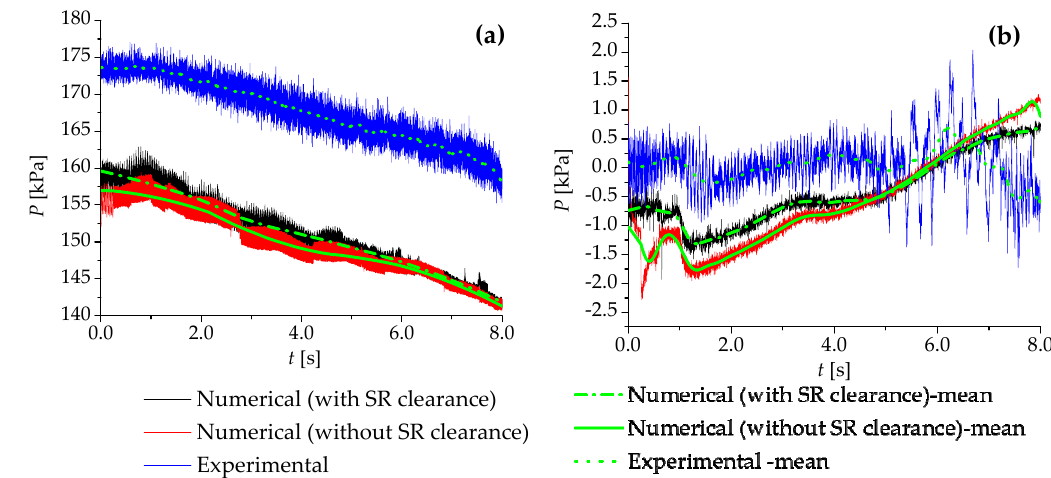
Figure 6. Numerical simulation and experimental model test results for the Francis turbine with and without an SR clearance under a load rejection condition. ( a ) The pressures p in the vaneless zone; and, ( b ) The pressures p in the draft tube.